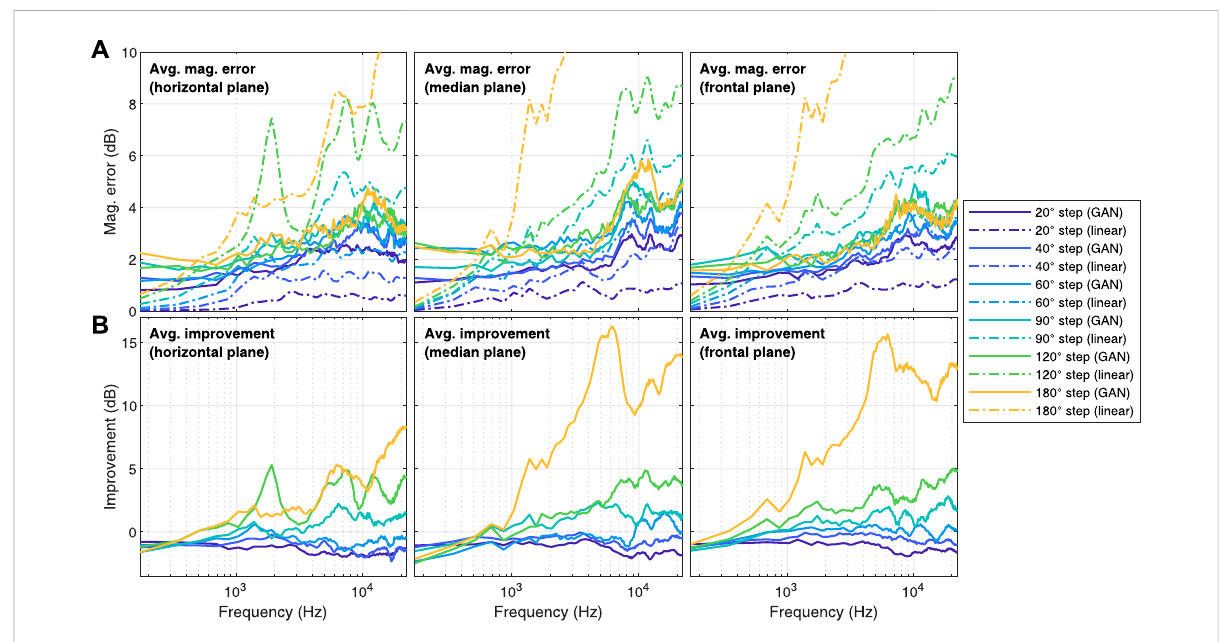
FIGURE 3 (A) :magnitudeerror, averagedoverbothearsand overall availabledirections. (B) :improvement oftheGANcompared withlinear interpolation (values greaterthan zeroindicatethat theGAN obtained alowermagnitude errorthanlinear interpolation). Data weresplitinhorizontal,median and frontal planes.